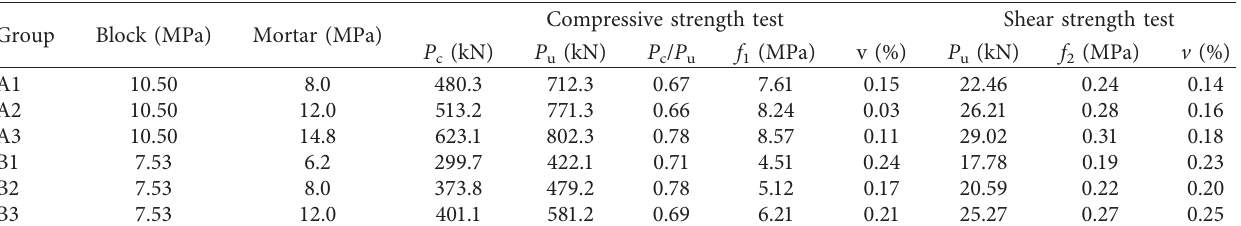
Figure 10: Specimens employed for testing shear strength. (a) Dimensions (mm); (b) shear test; (c) shear failure. Table 6: Compressive and shear strength of RCB